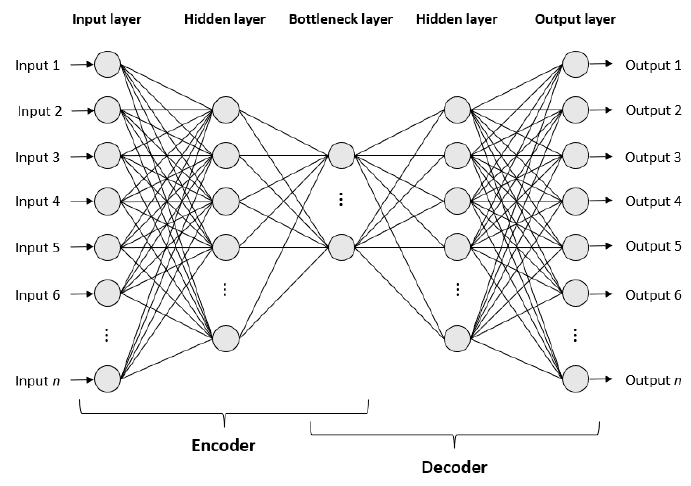
Figure 6. AANN Figure 6. AANN topology.